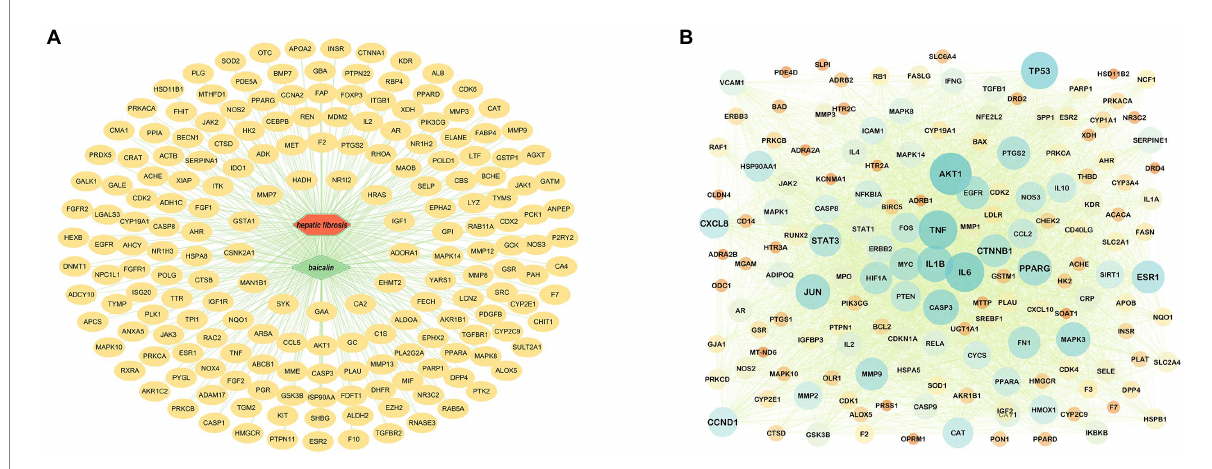
FIGURE 3 Target prediction and PPI core network analysis. (A) BA-targets (Green color in the center represents drug, red color represents diseases, and yellow color circles represent targets). (B) : PPI network